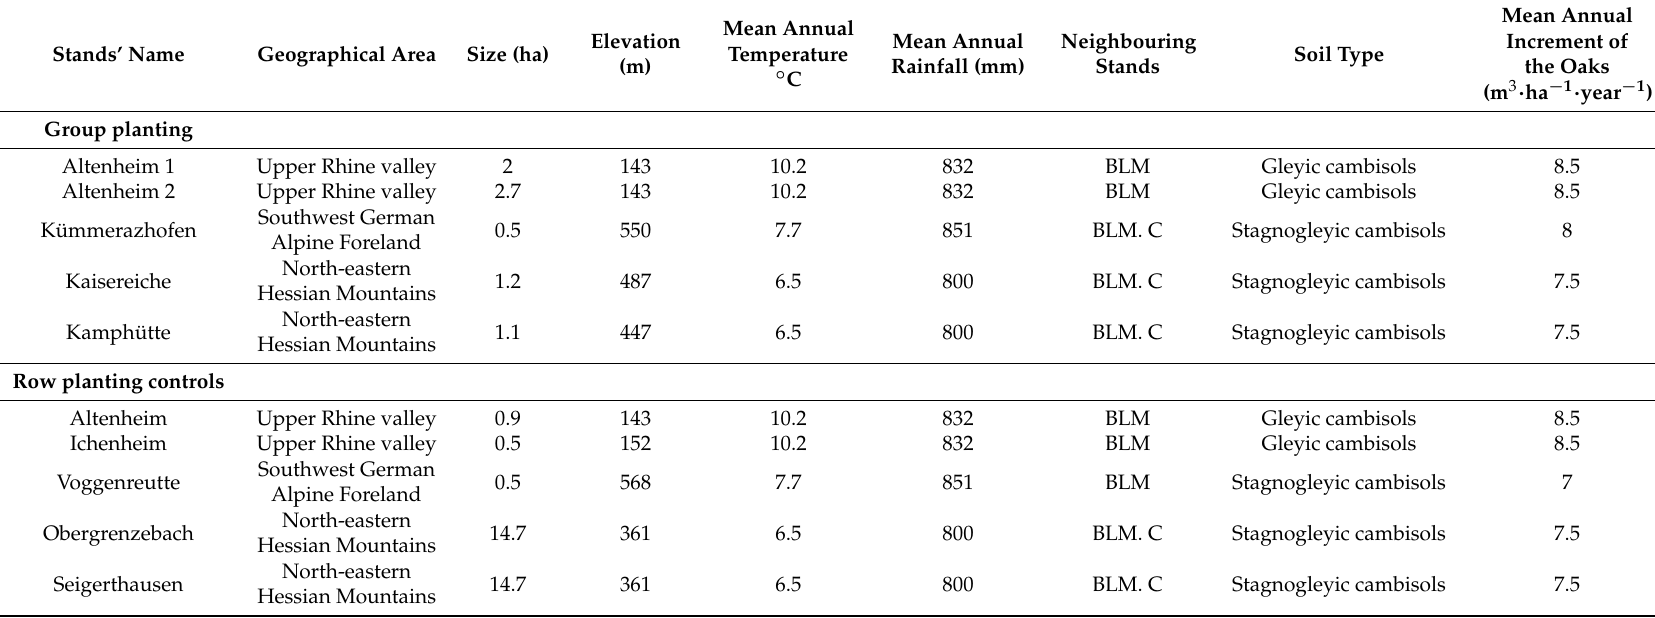
Table 1. Site characteristics of group and row planting stands. Neighboring stands column contains information about the composition of surrounding forests (BLM: Broadleaved mixed stands dominated by oak, C: Conifer stands dominated by Norway